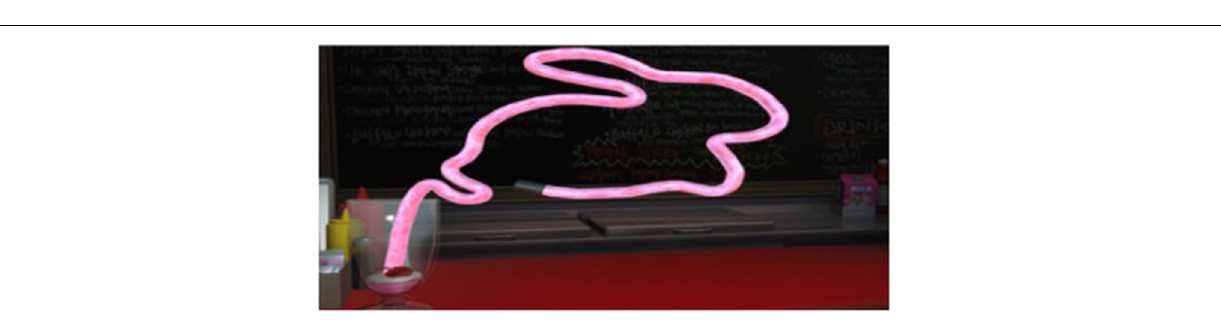
FIGURE 3 | Example of Rabbit shape requiring visually guided tracing in the SLURP